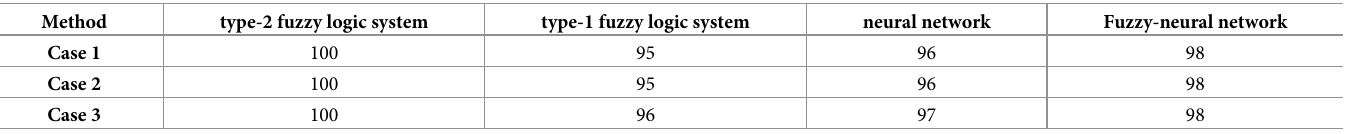
Table 7. Comparison of percentage of detection by different methods in scenario